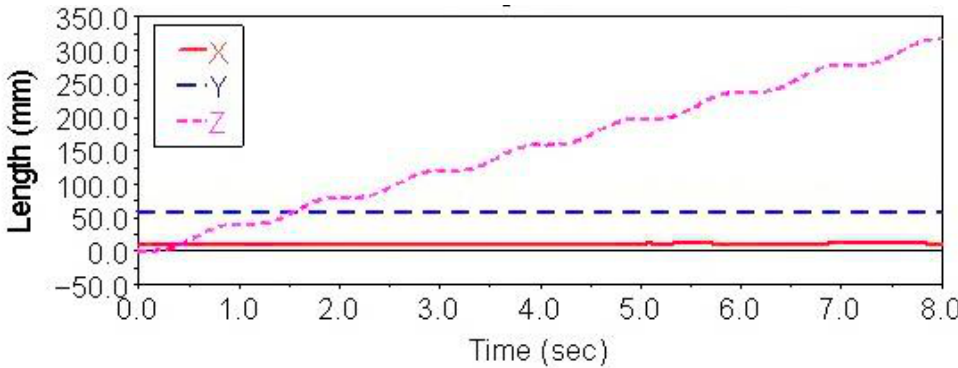
( d ) Control signal of the right rear leg. Figure 10. Robot leg control signals using the diagonal gait for crossing over obstacles.